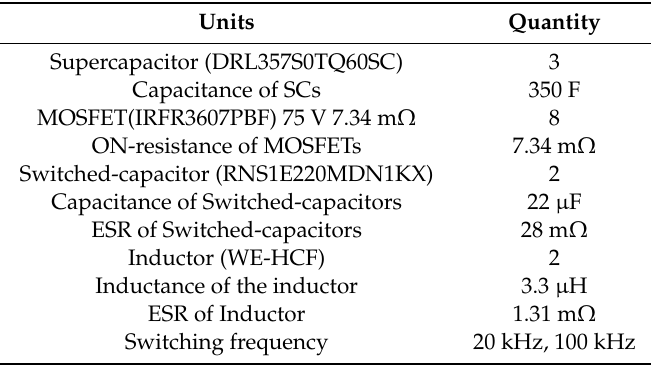
Figure 10. The supercapacitor test platform. Table 3. Parameters in the experiment.